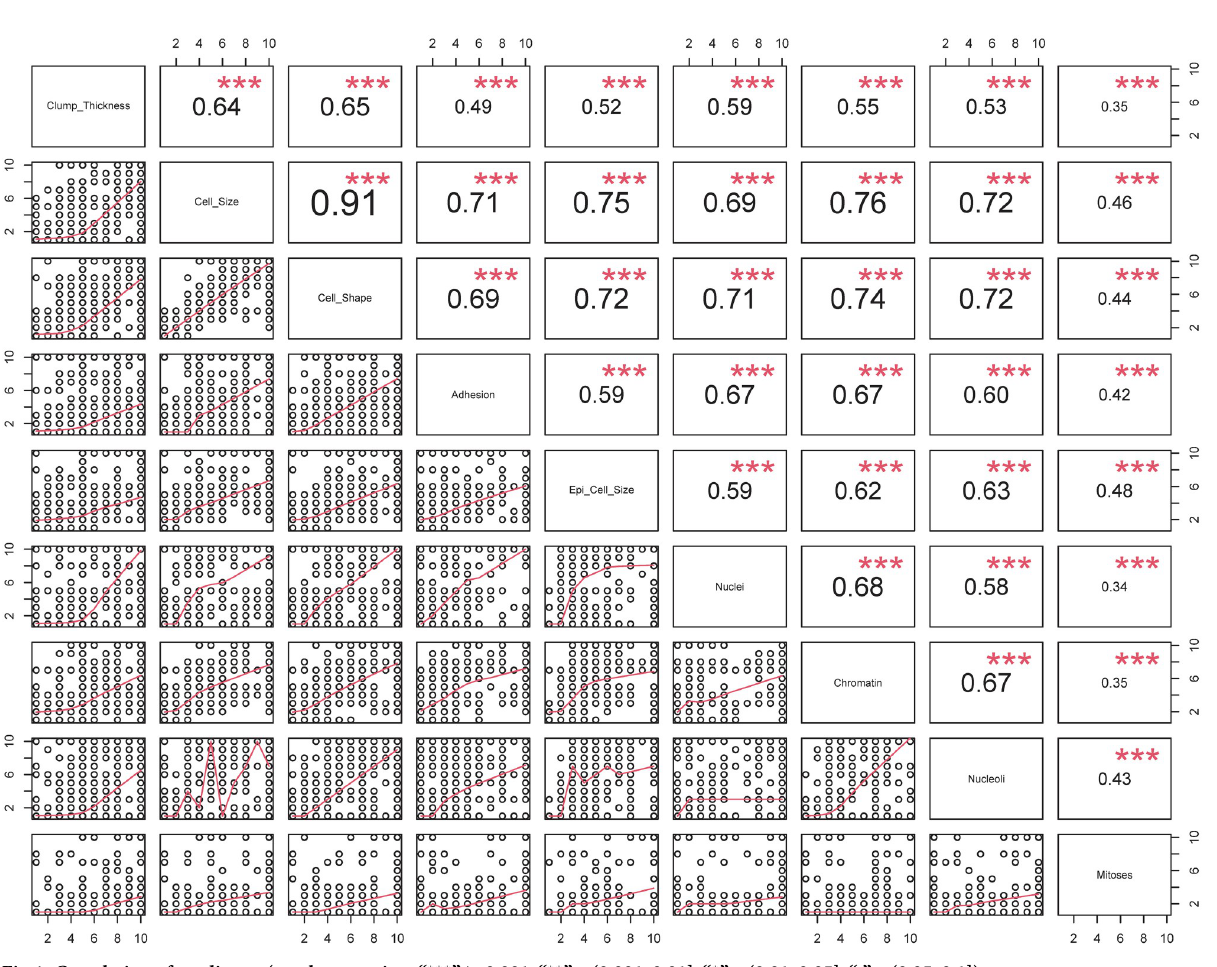
Fig 4. Correlation of predictors ( p -value notation: “ ��� ” � 0.001, “ �� ” – (0.001, 0.01], “ � ” – (0.01, 0.05], “.” – (0.05, 0.1]).